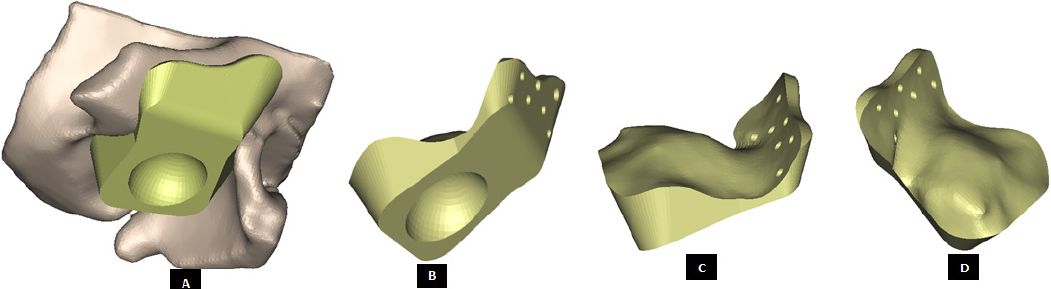
Figure 15. Patient-specific design of fossa prosthesis. Inferior rectangular surface of the device has a circular grove for articulation with condylar head ( A , B ). Visuals illustrate customized size and shape of the device for accurate fit and fixation ( C , D ) to native anatomical structure. Superior edge of the lateral surface (which hosts screw holes) is custom cut to follow the curvature of native eminence and bone situation.